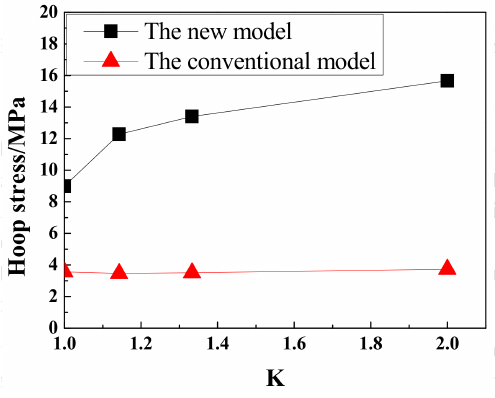
Figure 11. Hoop stress of cement sheath vs. anisotropy index (k).